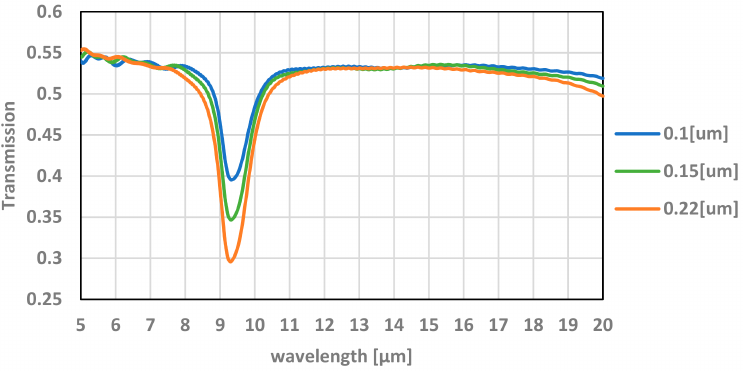
Figure 15. The effect of the thickness of the oxide on the transmission of the optical window. The simulation is achieved with PSA averaging and δ = 0.6 (THz).